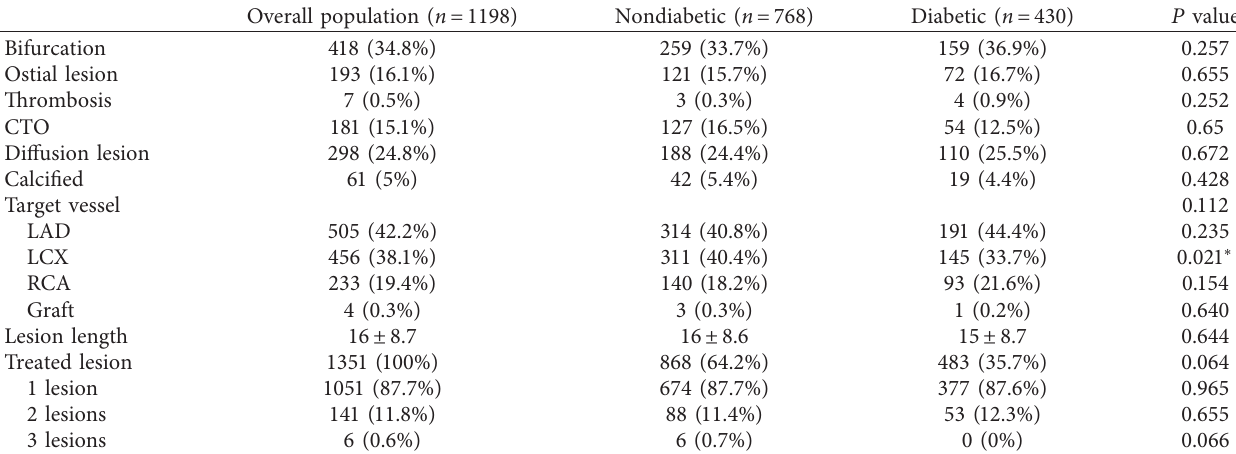
Table 2: Baseline lesions characteristics.